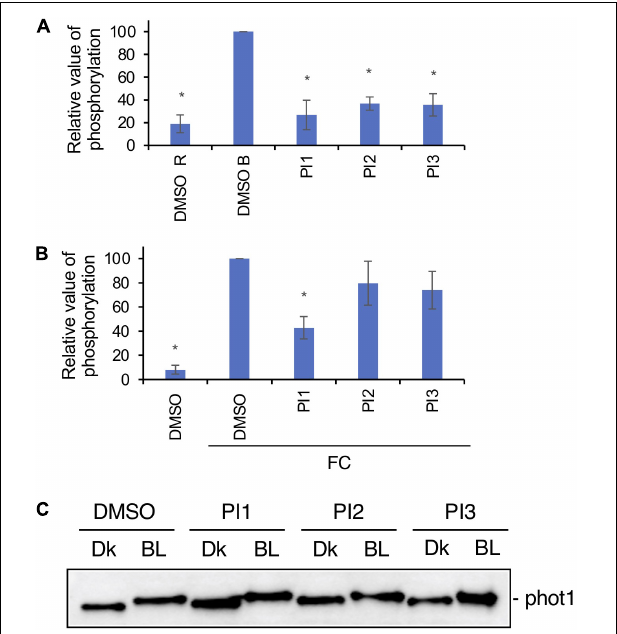
FIGURE 3 | Effects of PIs on phosphorylation of PM H + -ATPase in guard cells and phototropin. (A) Inhibition by PIs of BL-dependent H + -ATPase phosphorylation in guard cells of Arabidopsis. Leaf epidermis was pre-treated with compounds for 20 min in the dark and illuminated with 50 µ mol m − 2 s − 1 red light for 20 min (DMSO R), after which 10 µ mol m − 2 s − 1 BL was superimposed on the red light for 2.5 min (DMSO B, PI1, PI2, PI3).